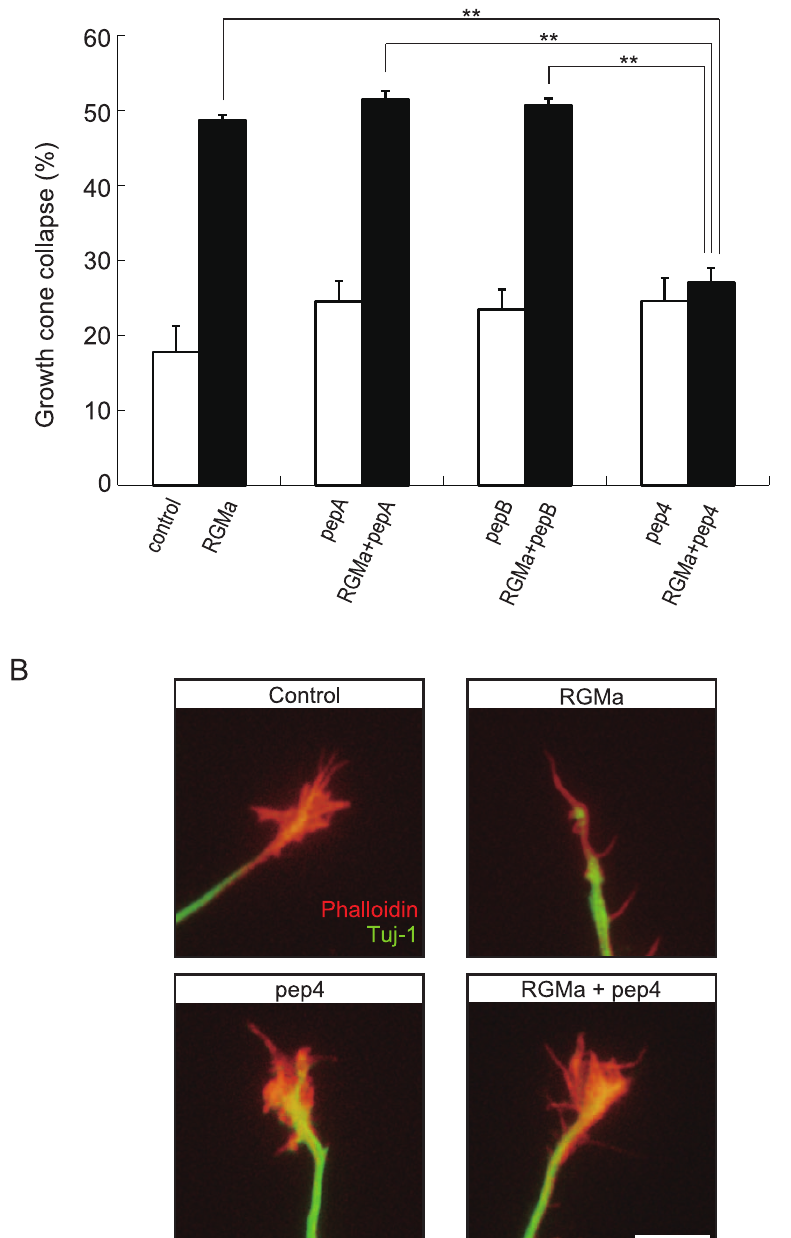
Figure 3. RGMa peptide 4 (aa 284–293) inhibits RGMa-induced growth cone collapse. (A) Effects of RGMa peptide 4 on RGMa-induced growth cone collapse. Cortical neurons were treated with RGMa and/or RGMa peptides for 30 min. The results were quantified from 3 independent experiments, and the percentage of collapsed growth cones is shown (** P , 0.01). Pep4, peptide 4; PepA, Peptide A; PepB, peptide B. (B) Representative images of growth cones. Red: Phalloidin, Green: Tuj1. Scale bar: 10 m